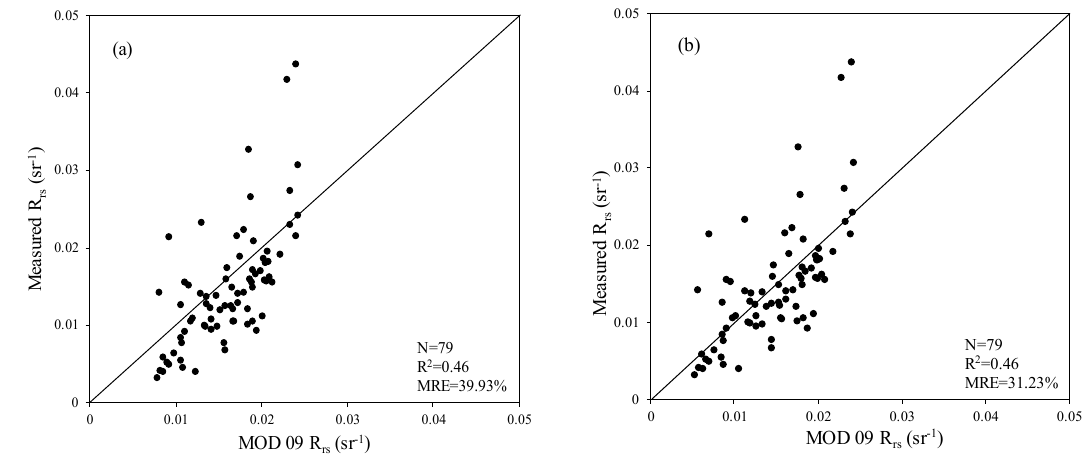
Figure 2. Measured above-surface remote-sensing reflectance (R rs ) and R rs derived from MODIS surface reflectance product (MOD09) at 748 nm ( a ) before recalibration and ( b ) after recalibration.